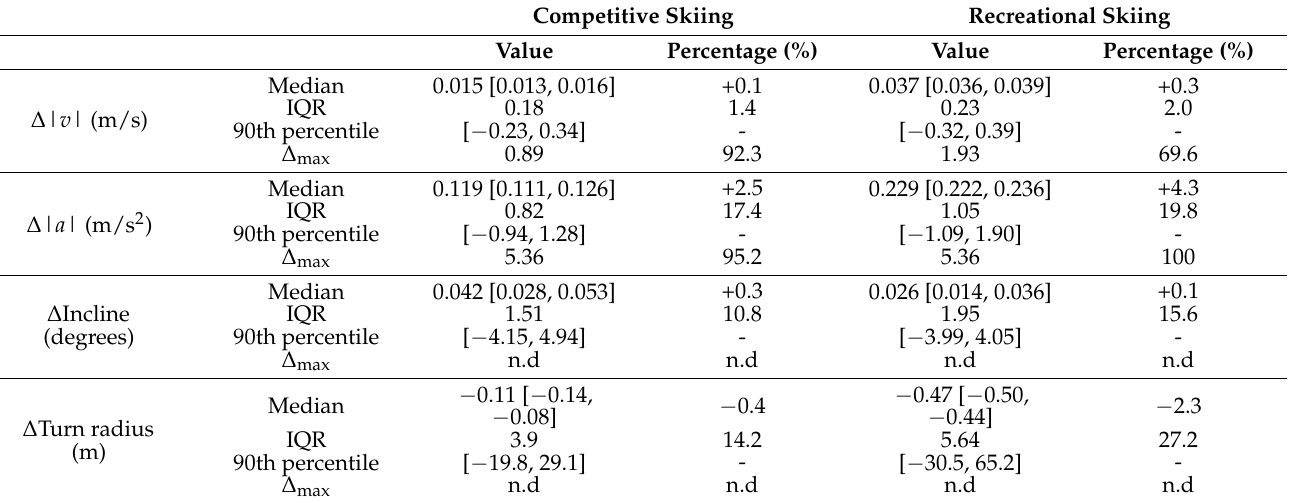
Table 4. Instantaneous errors for speed ( ∆ | v |), acceleration ( ∆ | a |), trajectory incline ( ∆ Incline), and turn radius ( ∆ Turn radius), for competitive and recreational skiing. Data presented with median (with confidence intervals), interquartile range (IQR) and maximal error ( ∆ max) in parameter units and %. Not defined (n.d). Competitive Skiing Recreational Skiing